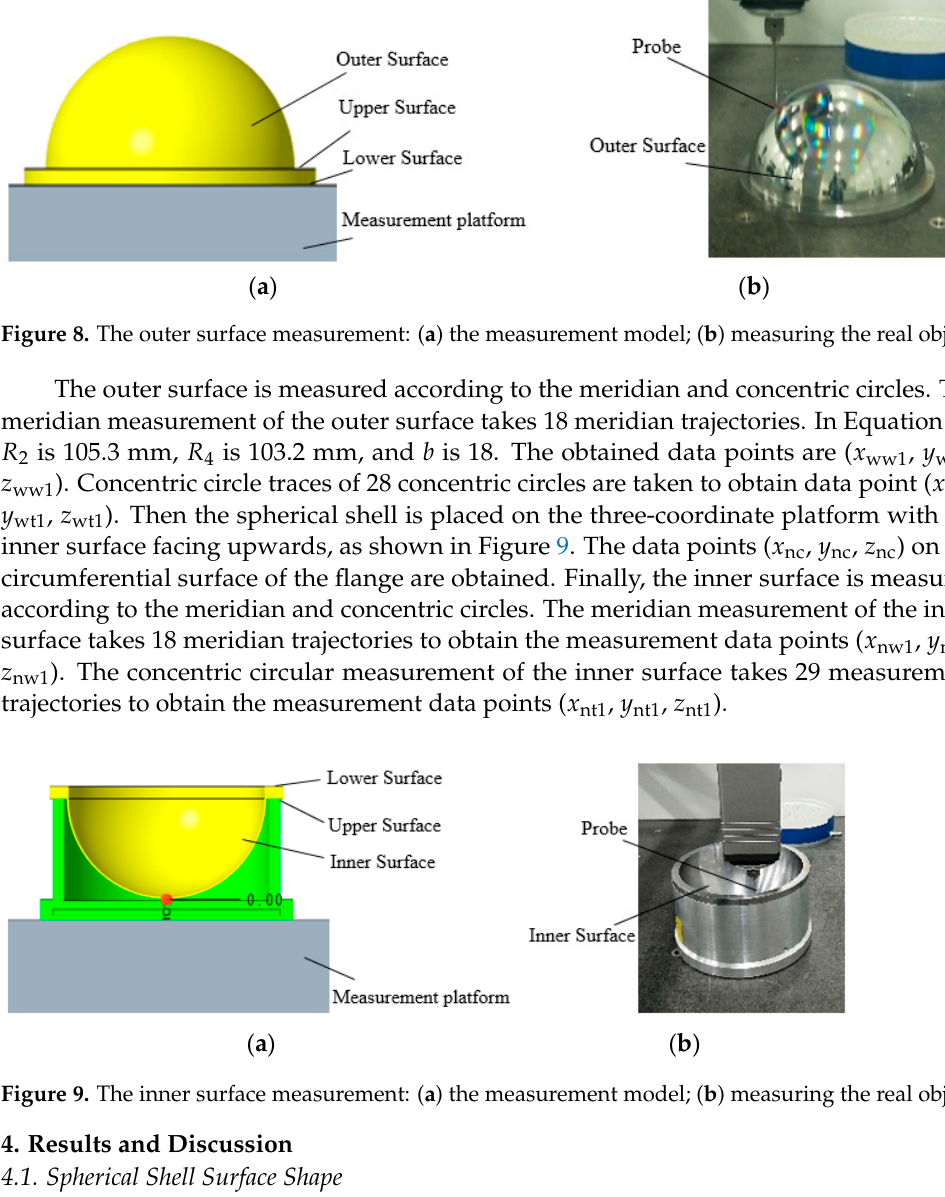
( d ) Figure 10. The surface error distribution: ( a ) Surface error distribution of the outer surface (the meridian trajectory); ( b ) surface error distribution of the outer surface (the concentric trajectory); ( c ) surface error distribution of the inner surface (the meridian trajectory); ( d ) surface error distribution of the inner surface (the concentric trajectory).